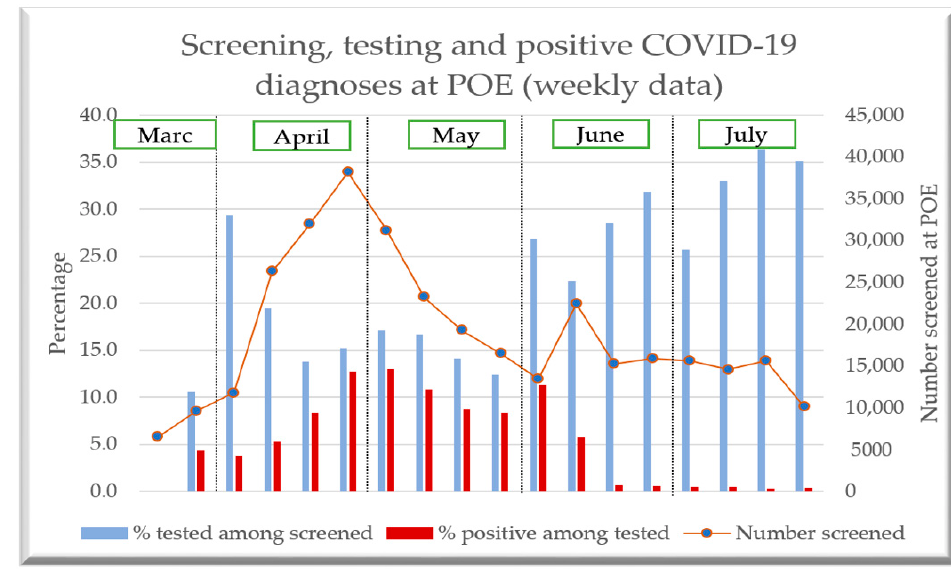
Figure 3. Screening, testing and positive COVID-19 diagnoses in travelers by week at all POE, Nepal: 19 March 2021–15 July 2021. COVID-19= Corona Virus Disease-19; POE = Points of Entry.